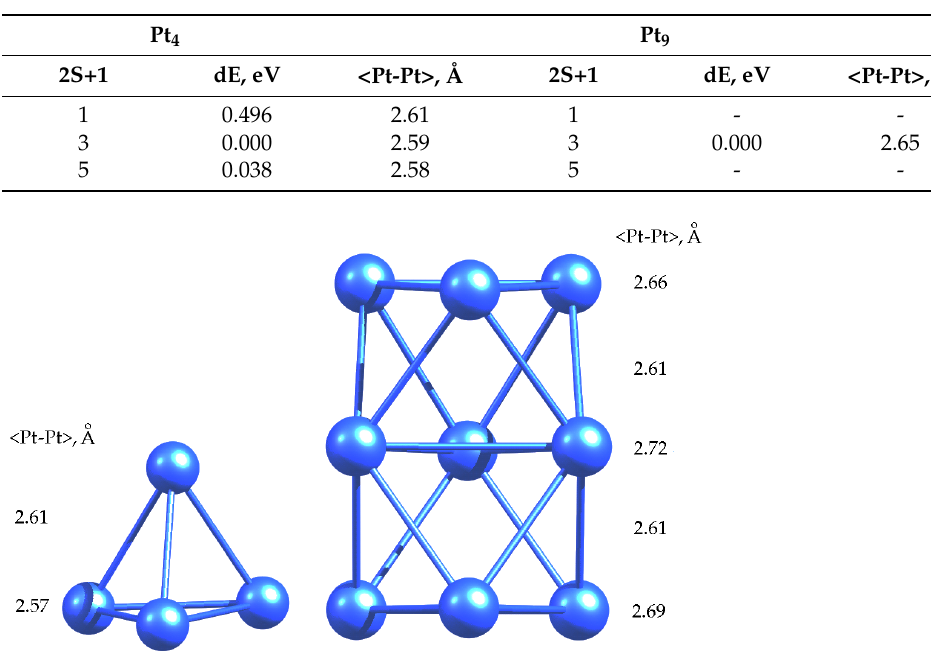
Table 6. Results of geometry calculations for Pt 4 and Pt 9 .